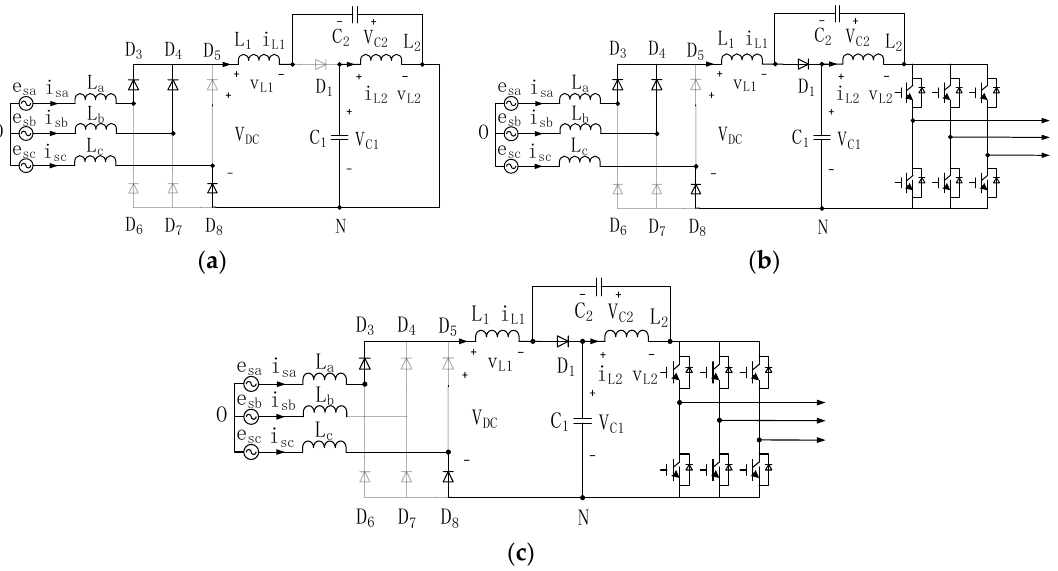
Figure 9. The equivalent circuit of quasi-Z-source inverter (qZSI) wind power generation system in each modes: ( a ) Mode 1; ( b ) Mode 2; ( c ) Mode 3. each modes: ( a ) Mode 1; ( b ) Mode 2; ( c ) Mode